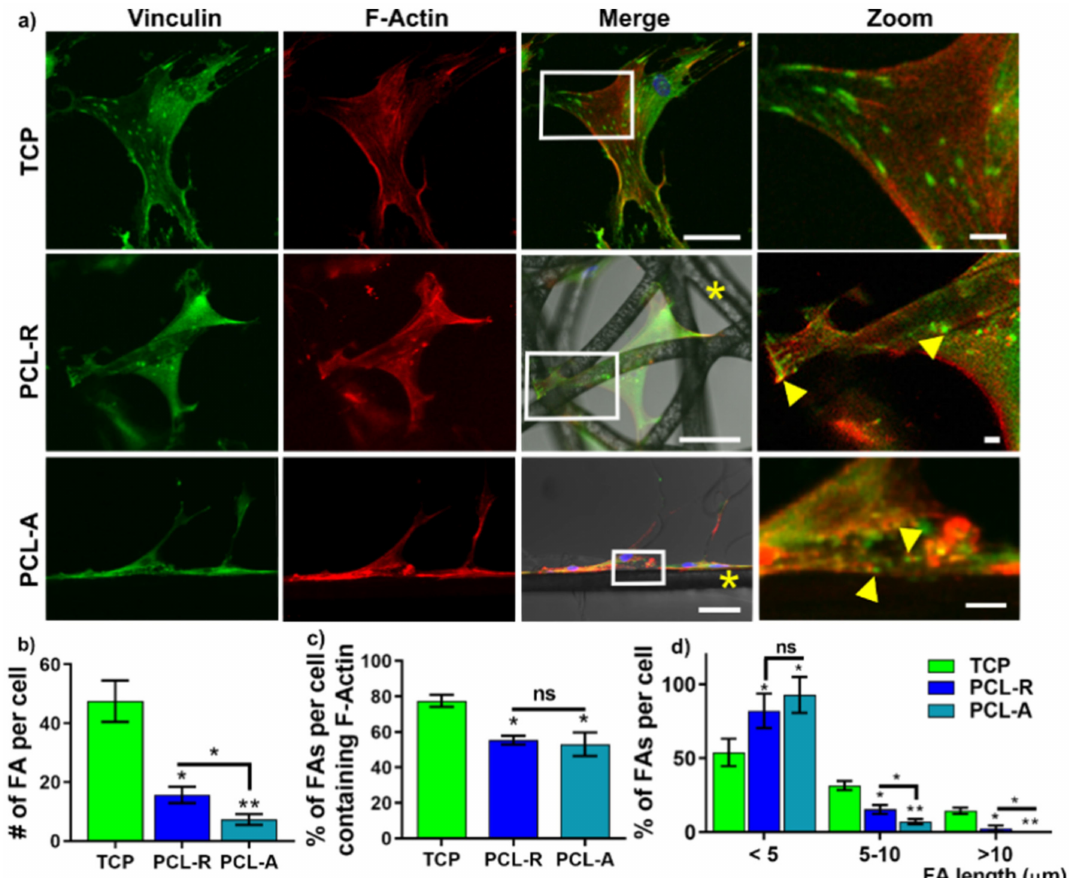
Figure 2. Osteoblast cell shape and focal adhesion on the 3D PCL groups and 2D TCP at 24 h. Representative confocal images ( a ) and quantification ( b – d ) of vinculin in hOBs (>15 cells per group per donor). * PCL fibers; arrows: focal adhesions (FAs); Scale: 50 µ m in low-magnification, 10 µ m in zoom. * p < 0.05, ** p <